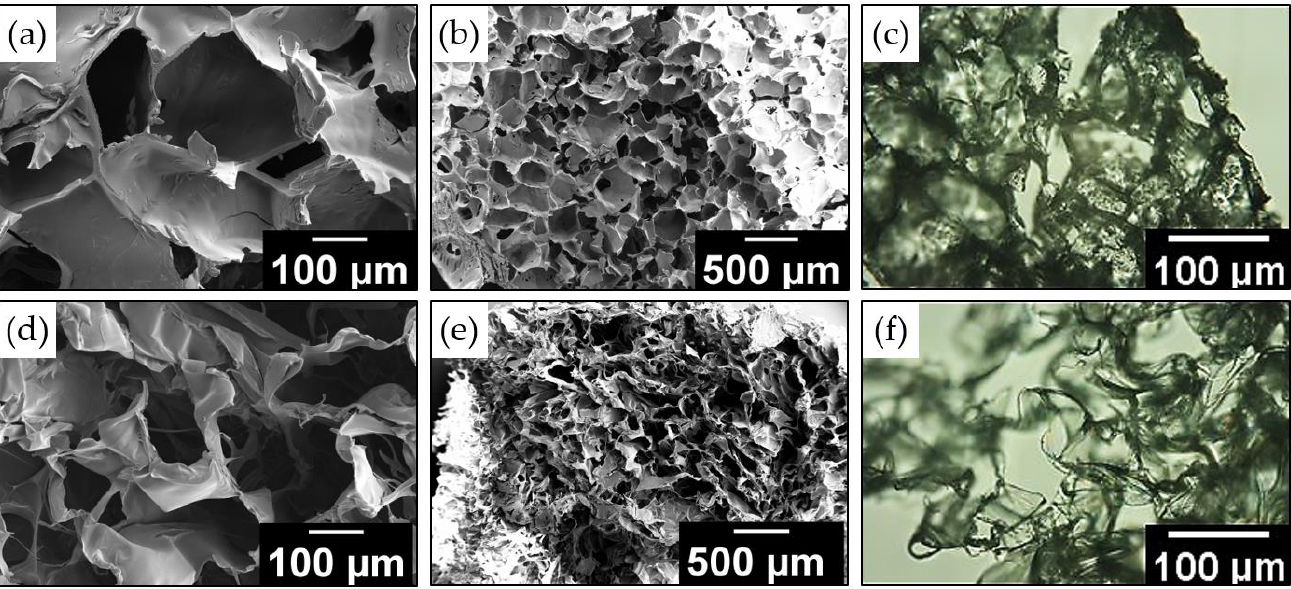
Figure 3. ATR-FTIR ( a ) and CP/MAS 13 C NMR ( b ) spectra of obtained cryogels (sample 2).